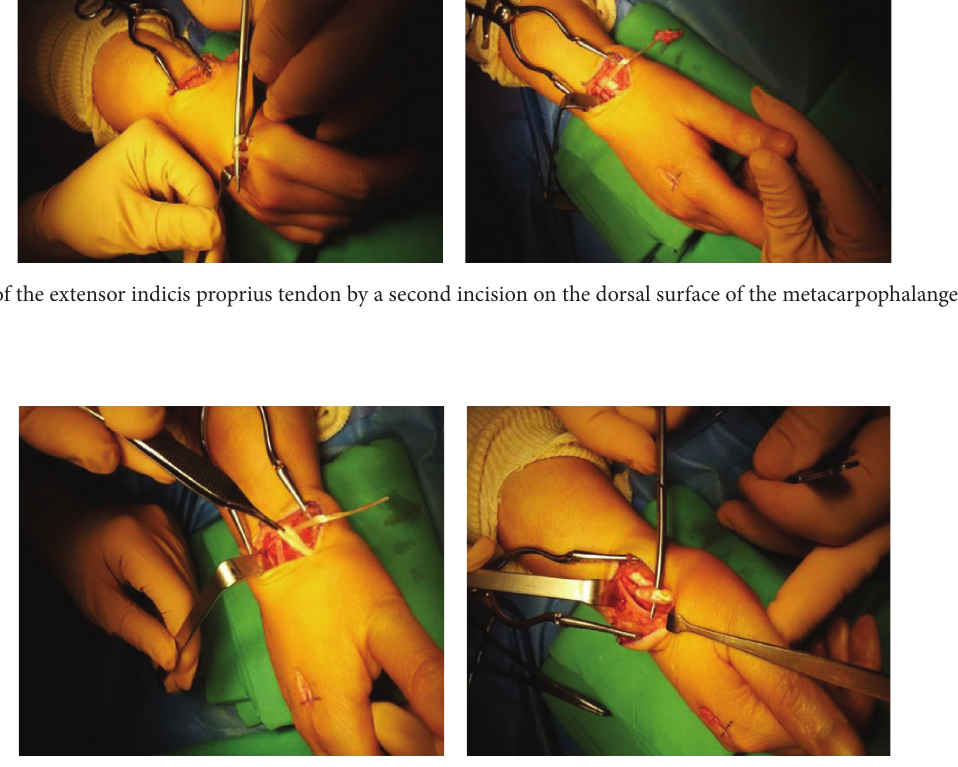
Figure 5: Intraoperative view after final adjustment and reconstruction of the extensor pollicis longus